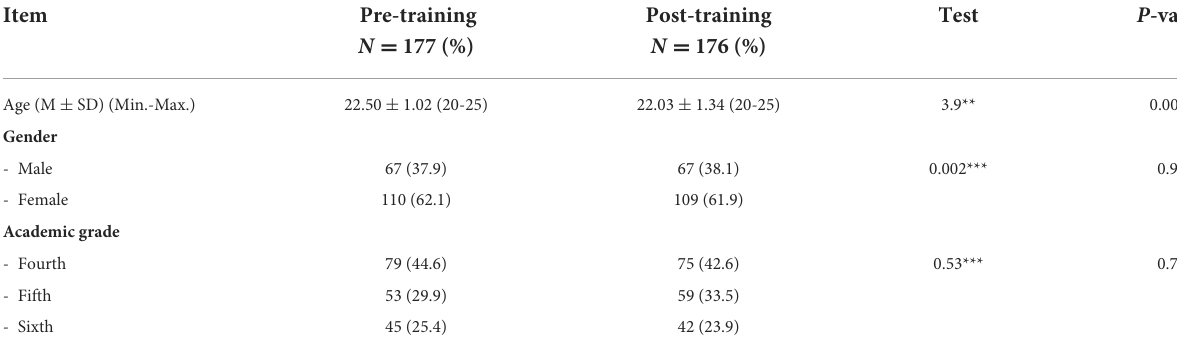
TABLE 1 Demographic data of the participants before and after infection control training.